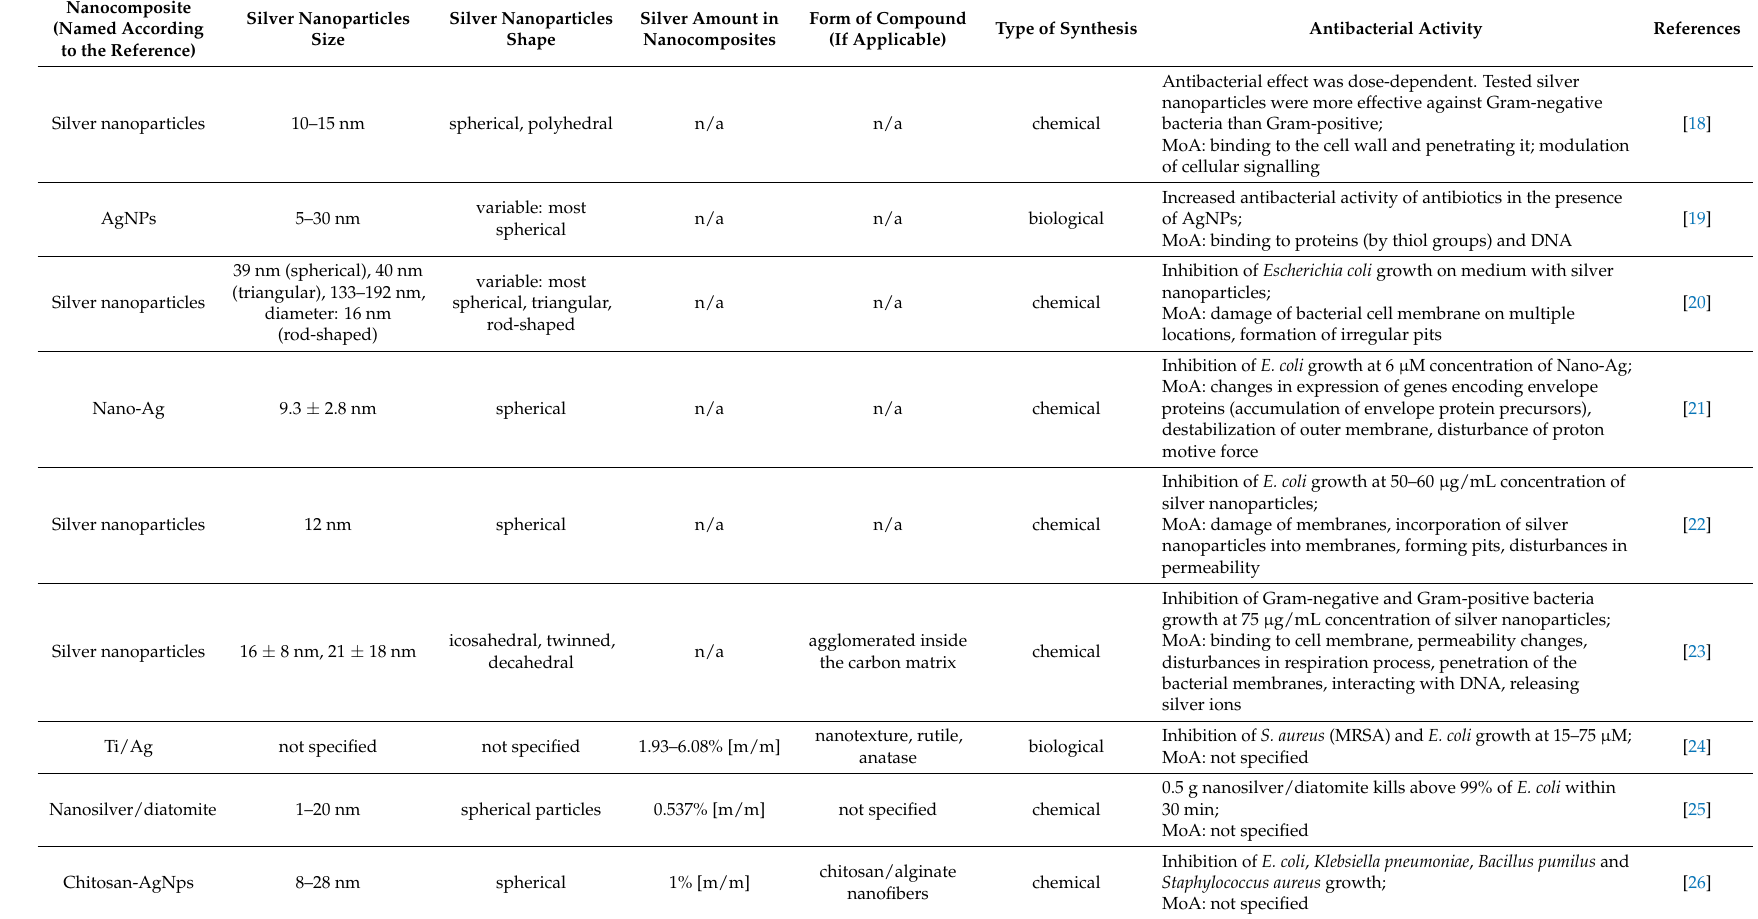
Table 1. Overview of certain nanocomposites of silver: their physico-chemical description and biological